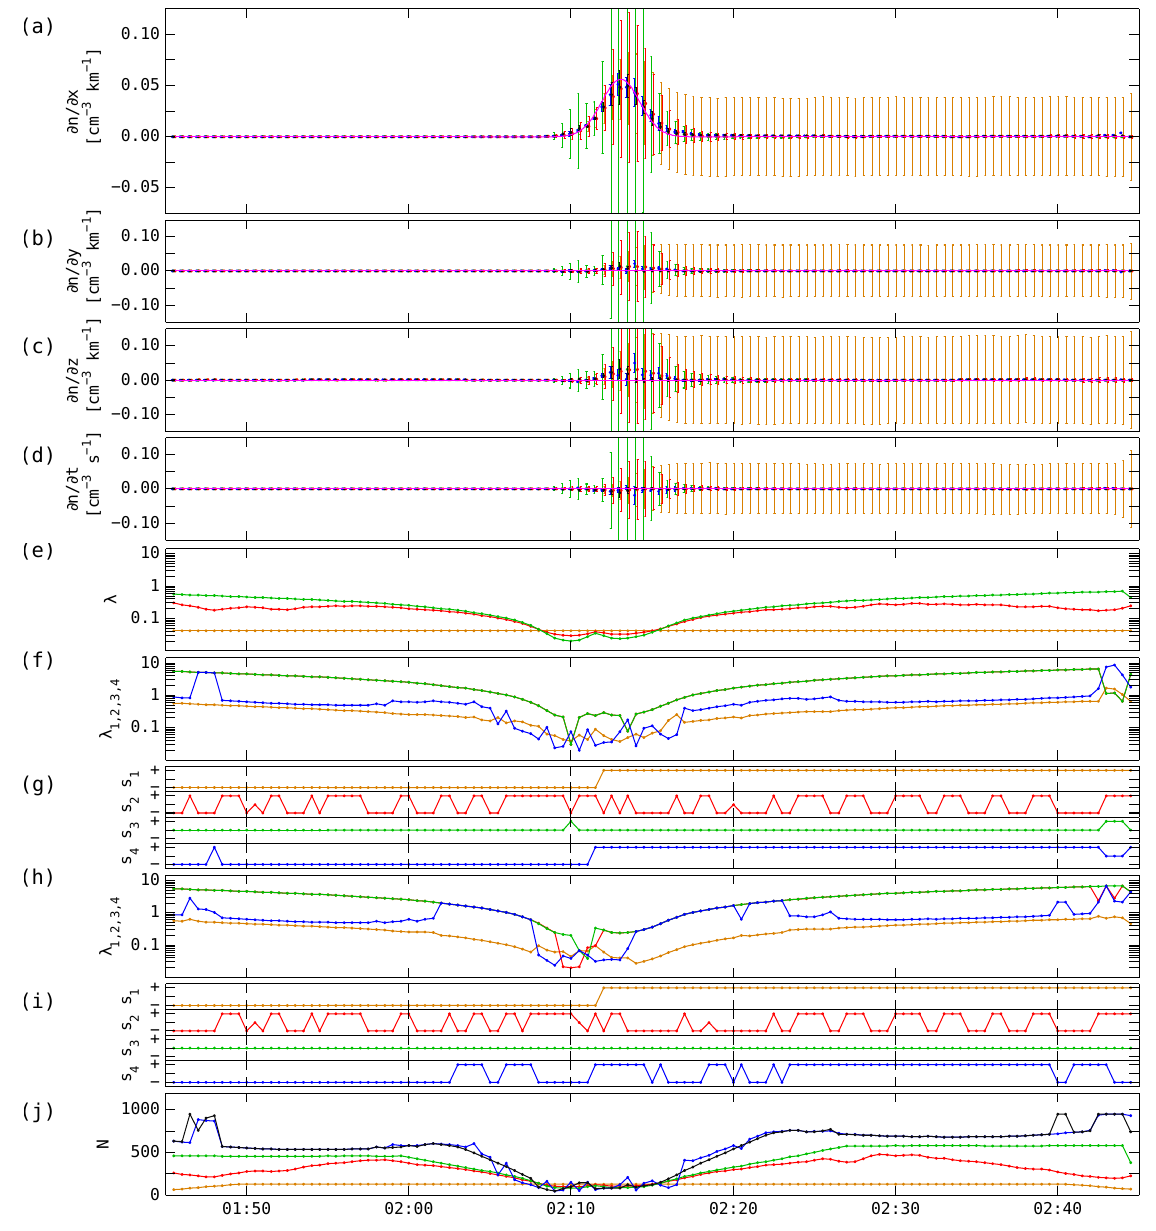
Fig. 9. Least-squares gradient at a density interface (4 spacecraft, medium separation, 5% measurement error, smoothed at a 30s time